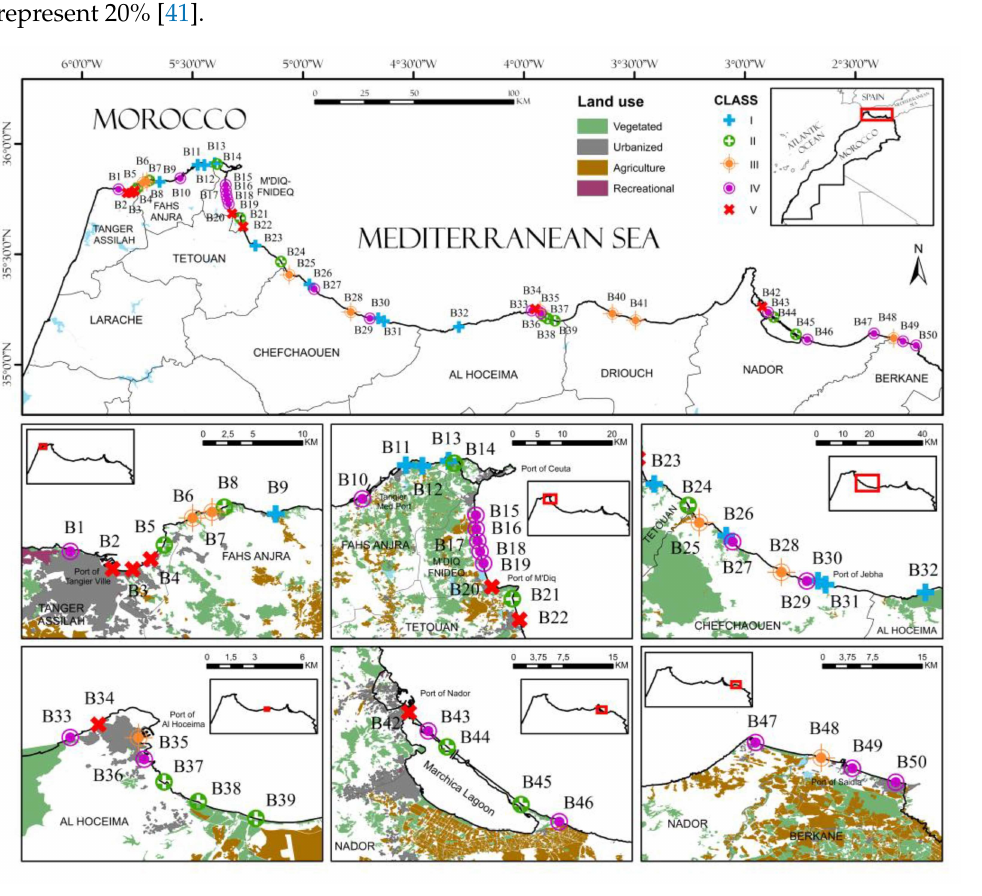
Figure 1. Location map of the sites studied with indications of their land use and scenic